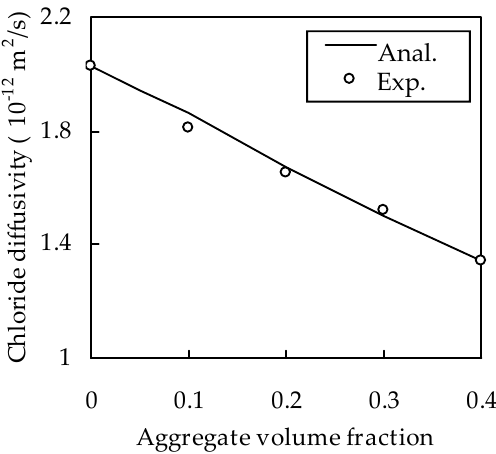
Figure 5. Comparison with experimental results of Yang and Su [41].